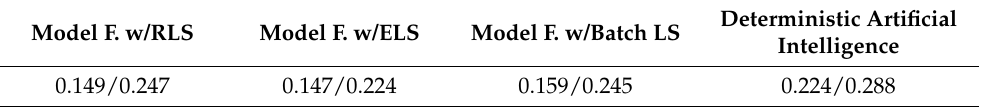
Figure 7. Results based on Equation (1) as opposed to Equation (2). Repeated from [6] comparing disparate modeling techniques (self-tuners without cancellation of process zeros) versus the identical deterministic artificial intelligence method used in this study. In this figure output is on ordinate with time in seconds on the abscissa. The reader is urged to compare the blue, thick dashed line in Figure 7 to the deterministic artificial intelligence results presented in Figure 6b. The difference is elaborated in Section 3.3. Table 2. Mean/Standard Deviation of Input Tracking Errors Using Equation (2).